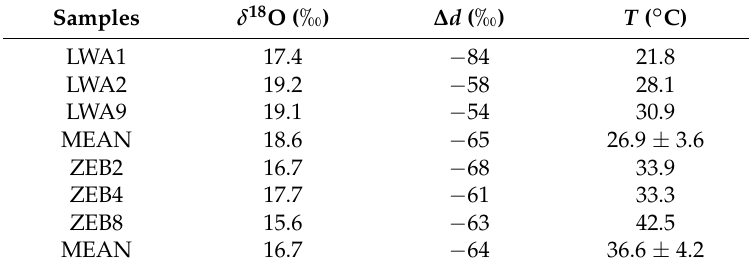
Table 8. Calculated temperatures of kaolinitisation ( T ) of the analysed samples.